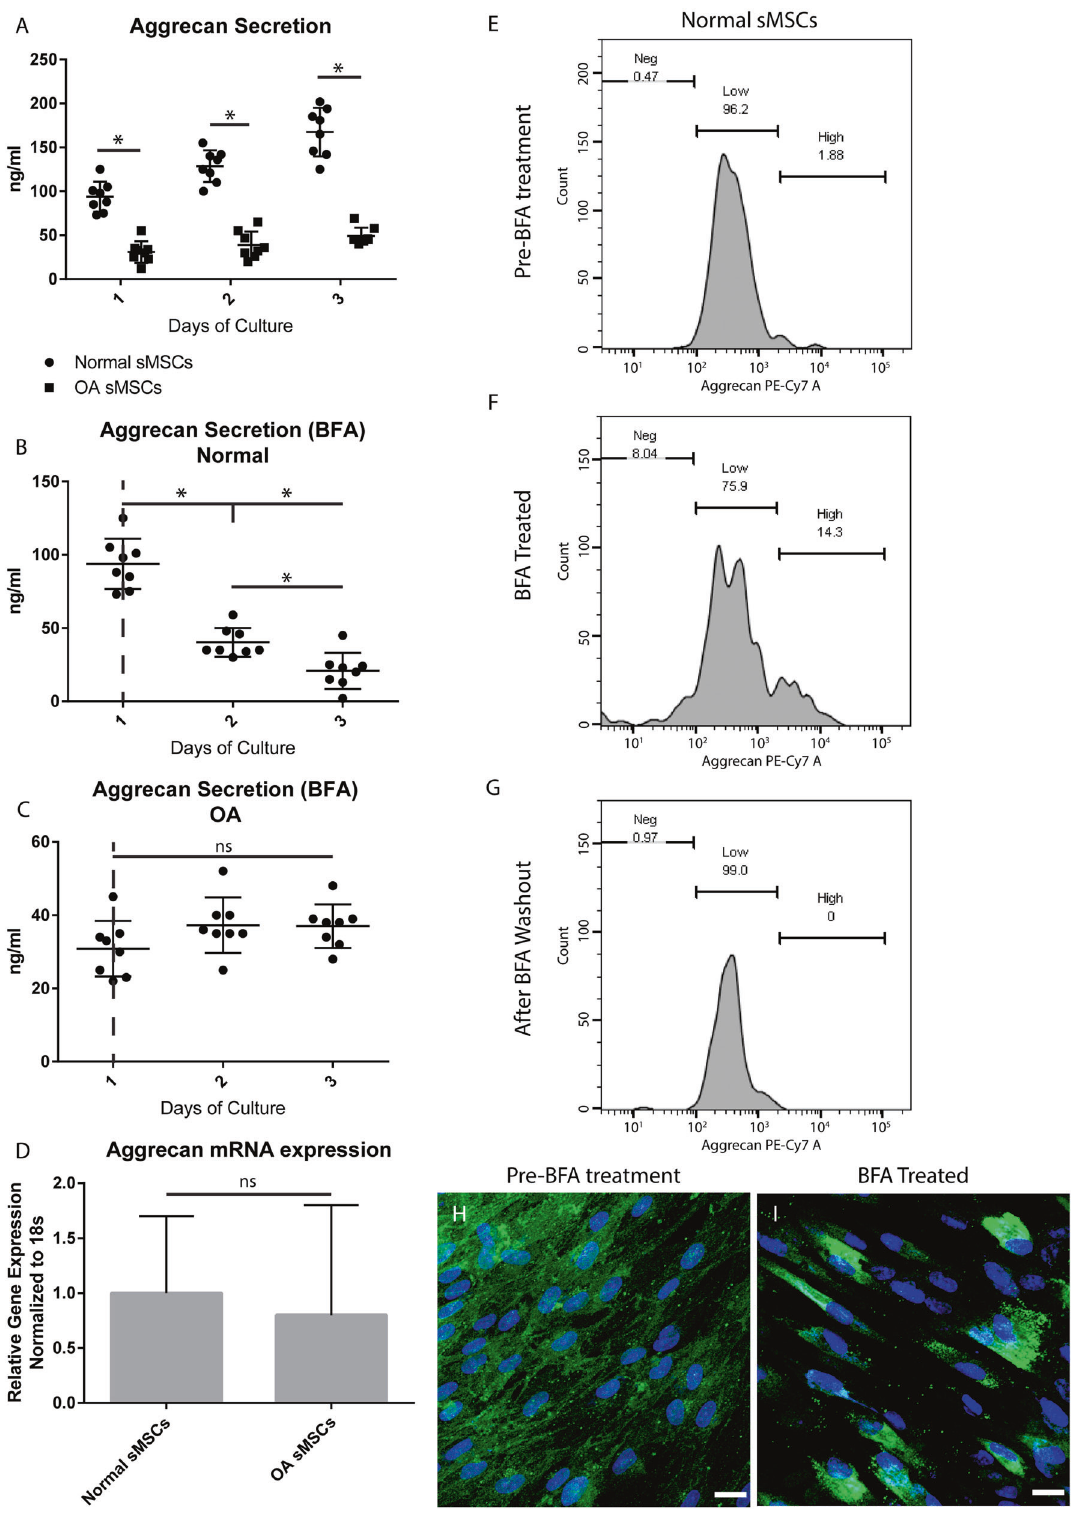
Fig. 3 Aggrecan secretion. Aggrecan secretion from normal and OA MPCs was analyzed by ELISA and it was found that OA MPCs secreted signi fi cantly less aggrecan than normal MPCs at all time points examined ( A ). To test if this phenotype was in part due to the inability of aggrecan to leave the ER/Golgi complex, normal ( B ) or OA ( C ) MPCs were treated with Brefeldin A (BFA). BFA treatment of normal MPCs signi fi cantly decreased aggrecan expression ( B ), while BFA treatment had no effect on aggrecan secretion in OA MPCs ( C ). To control for a difference in gene expression, mRNA in normal and OA MPCs was quanti fi ed, and no difference was observed ( D ). Flow cytometry ( E – G ) and immuno fl uorescence ( H , I ) was used to examine if BFA treatment of normal MPCs resulted in the same aggrecan staining phenotype observed in OA cells. BFA treatment resulted in a shift to high-positive gate ( E , F ) that was reversible with removal of BFA ( G ) and the intense aggrecan staining adjacent to the nucleus was also observed with BFA treatment ( I ). Scale bars equal 10 µm. * p < 0.05. Cell Death and Disease (2022)